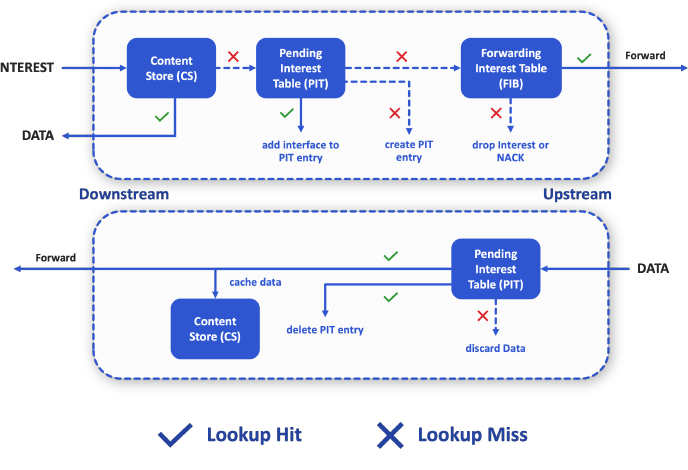
Figure 3. Forwarding process in